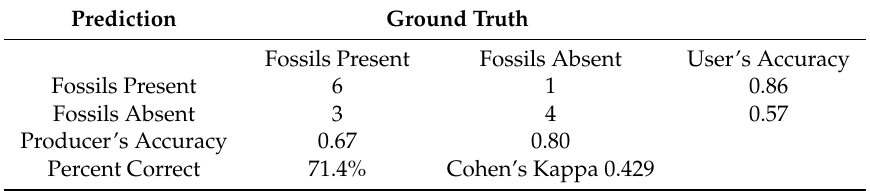
Table 5. Results of 2014 field season from the Dugout Draw area using the Landsat 8 OLI image.